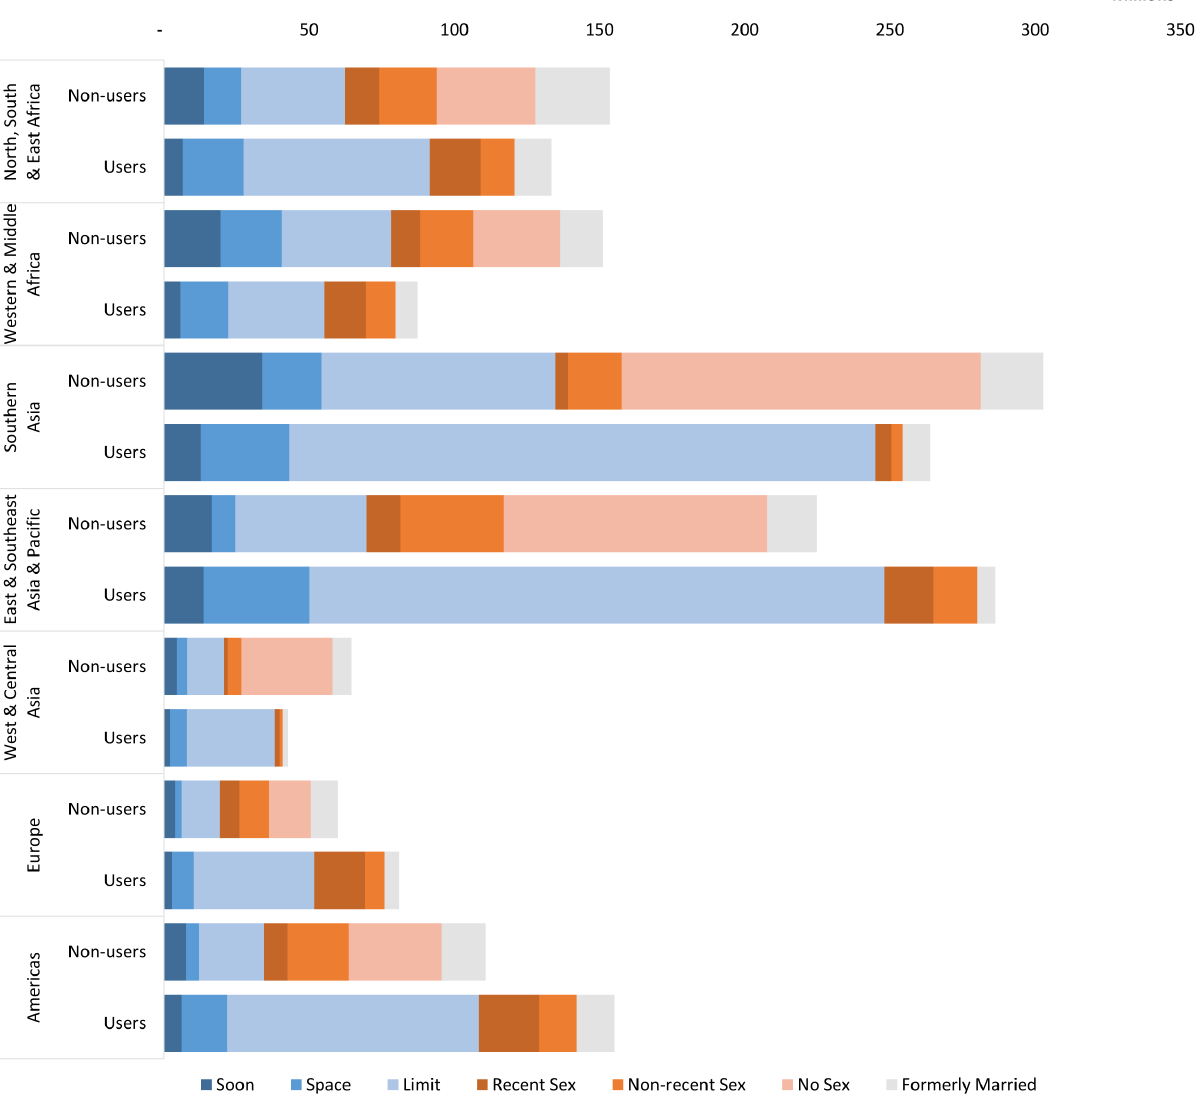
Figure 13. WRA by use, region and market segment in 2040, in millions. This graph shows all women of reproductive age (WRA) in 2040 distributed by region, market segment, and contraceptive use and non-use. Each region shows 2 stacked bars, the first shows non- users by market segment and the second shows users by market